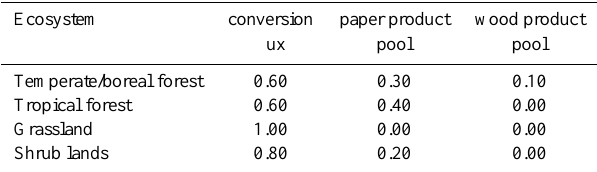
Table A3. The redistribution of carbon and nitrogen upon conver- sion used in CLM-CN. Factors are based on Houghton et al. (1983).